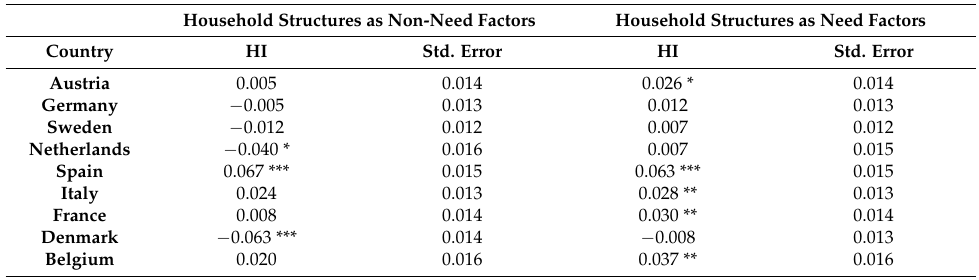
Table 4. Horizontal inequity in the use of home care (with alternative specification of household structure role). Household Structures as Non-Need Factors Household Structures as Need Factors